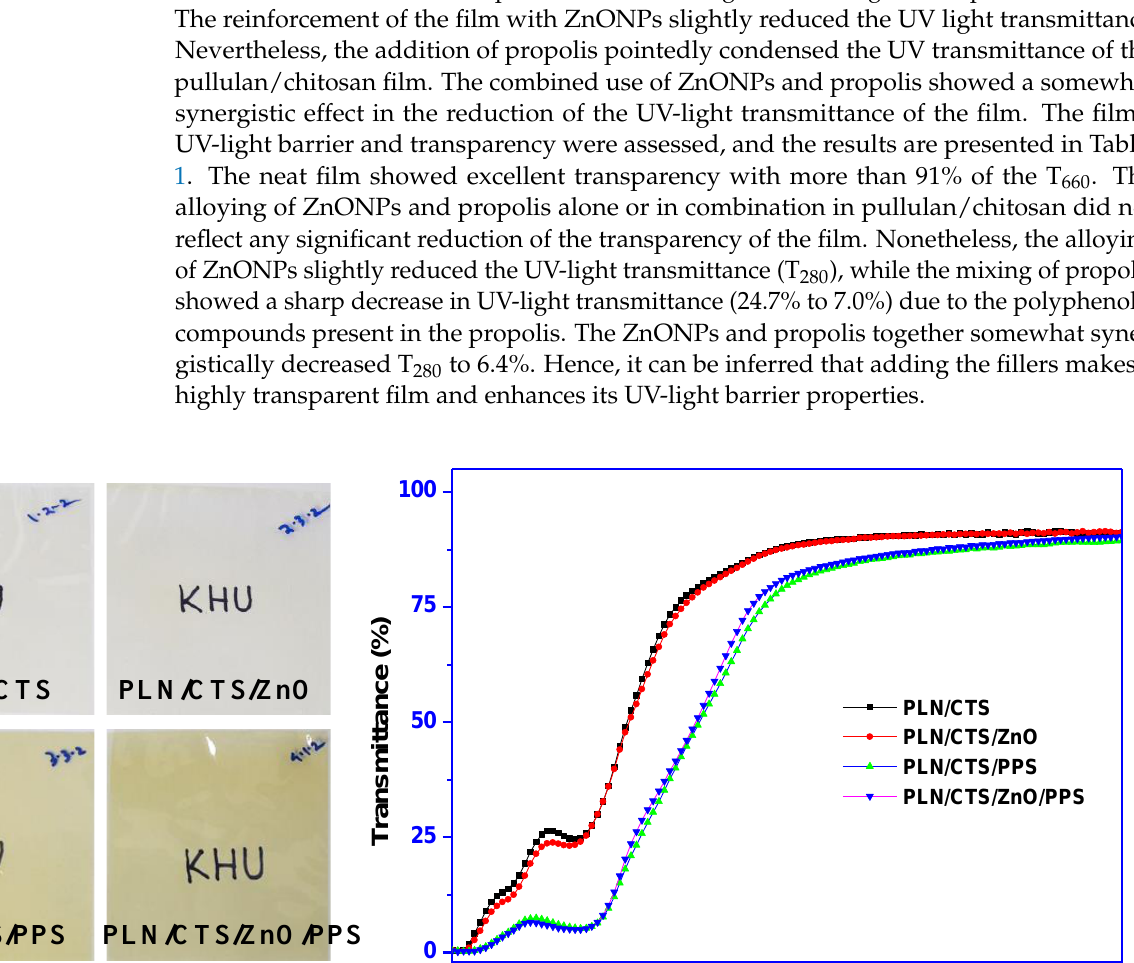
Figure 2. XPS spectra of ZnONPs.